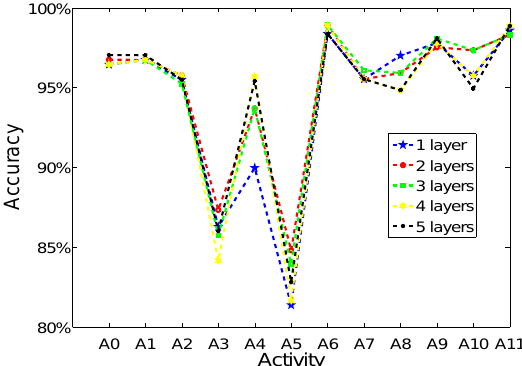
Figure 7. The performance of each activity recognition when selecting different numbers of hidden layer (iterations is set to 200, pretraining learning rate is set to 1 × 10 − 7 ; fine-tuning learning rate is set to